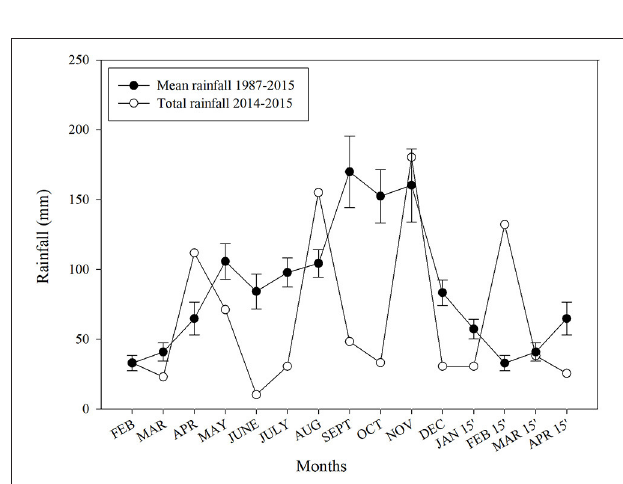
FIGURE 3 | Rainfall variability for Culebra Island. Black dots represent mean rainfall by months from 1987 to 2015 ( ± S.E.) and white dots represent total rainfall for research period from 2014 to